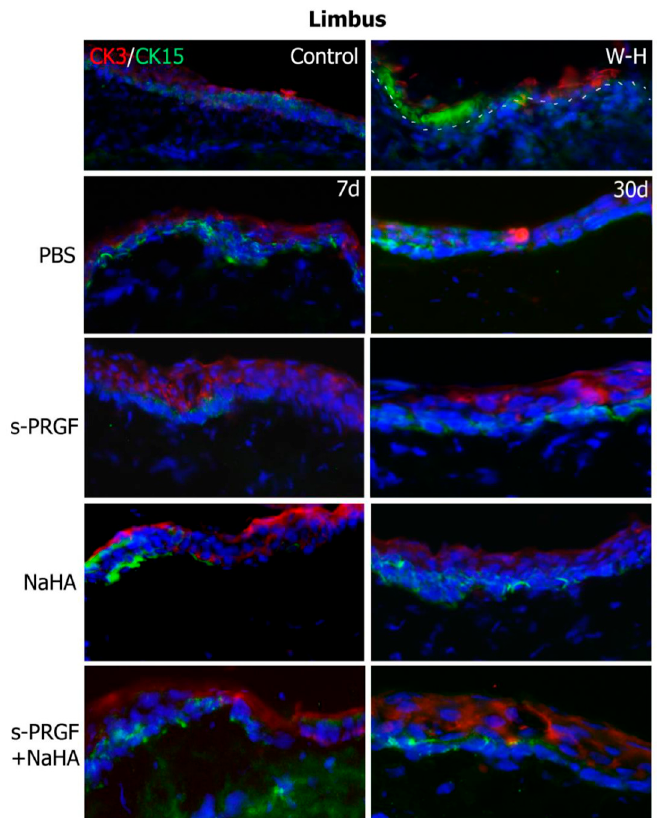
Figure 7. Fluorescent immunostaining for CK3 (red) and CK15 (green) on the limbal area of rabbit corneas after healing of the epithelial defect. Corneas were treated with s-PRGF, s-PRGF and NaHA, NaHA, or PBS (as a control) and were processed 7 and 30 days after cornea surgery. Control corresponds to a healthy rabbit cornea with no surgery. The W-H image shows a cornea processed 48 h after surgery without complete re-epithelialization. The dotted line shows the limit between the epithelium and stroma layers. Magnification 200×.